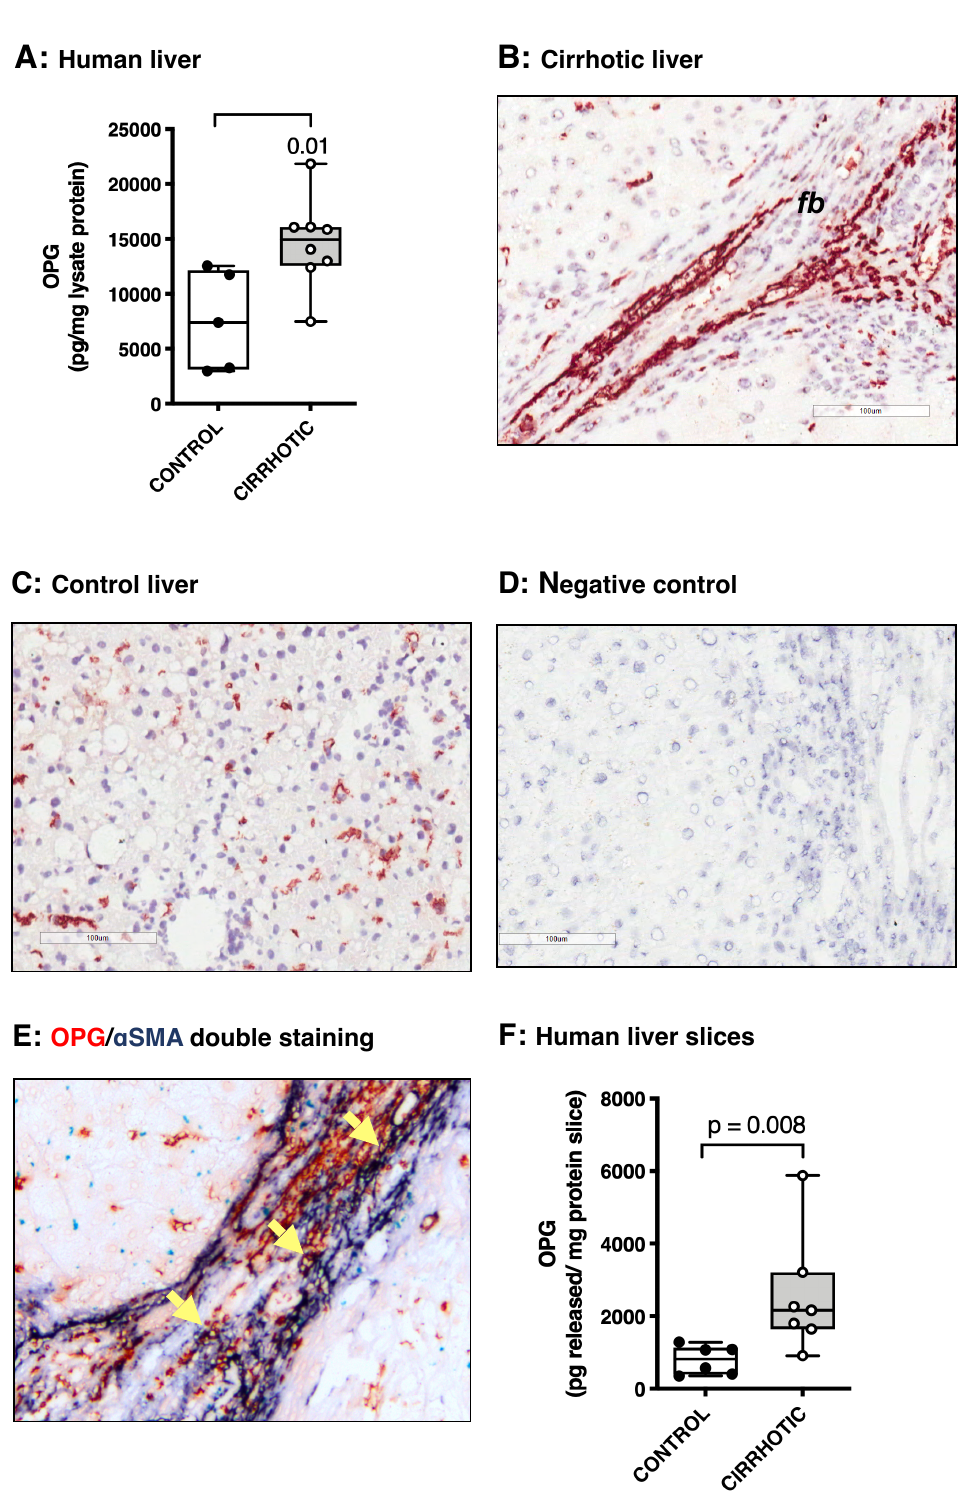
Figure 1. Osteoprotegerin(OPG)levelsarehigherinhumancirrhoticlivers. ( A )Lysatesofhumancirrhotic livers (n = 8) contained significantly more OPG than control livers (n = 5). ( B ) Immunohistochemical staining showed pronounced OPG expression (bright red staining) in fibrotic bands (fb) and expression scattered throughout relatively unaffected parenchymal tissue in human cirrhotic livers (200 × magnification). ( C ) OPG expression in control livers was only found scattered throughout the parenchyma (200 × magnification). ( D ) Negative control for the OPG staining (200 × magnification). ( E ) The